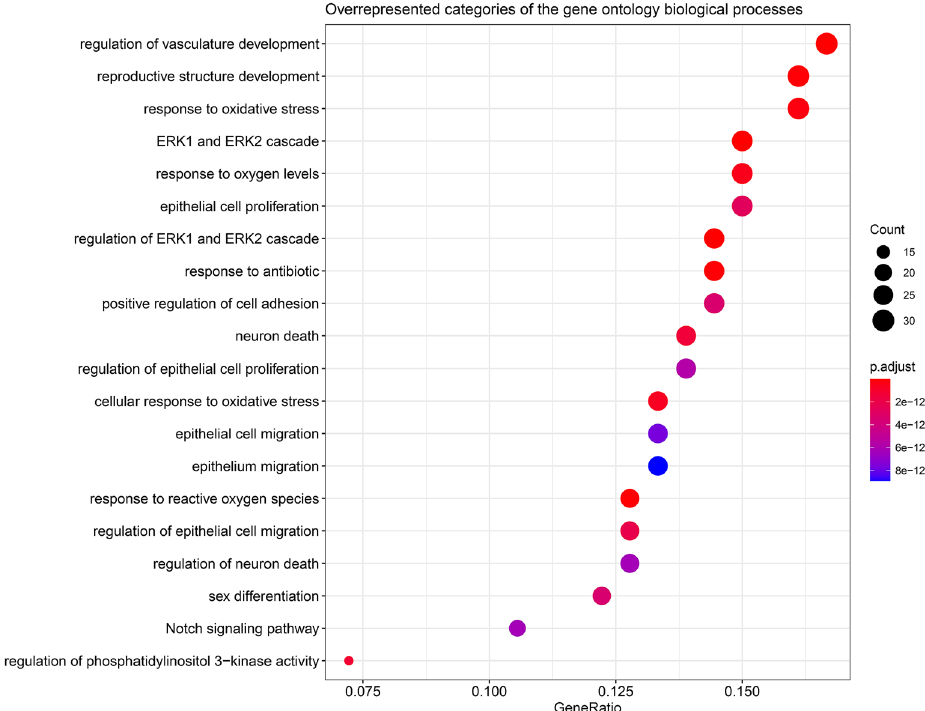
to our selected miRs. Dot sizes represent the number of genes (count) related to a particular BP. Gene Ratio is the number of genes found enriched in each category over the number of total genes associated to that BP. Dot colors represent the adjusted p values. Dot plots were generated in R software version 3.6.1 using the clusterProfiler package version 3.14.3 (https:// bioco nduct or. org/ packa ges/ relea se/ bioc/ html/ clust erPro filer.